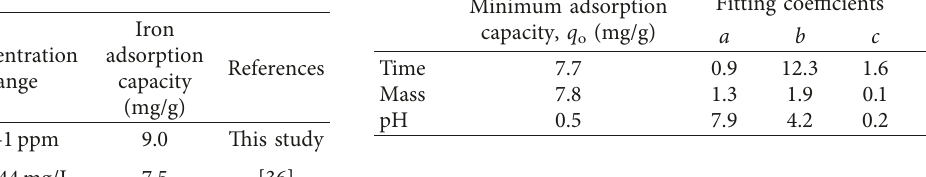
Table 1: Comparison of iron adsorption capacity of SiO from RHA with adsorbent materials in the references.